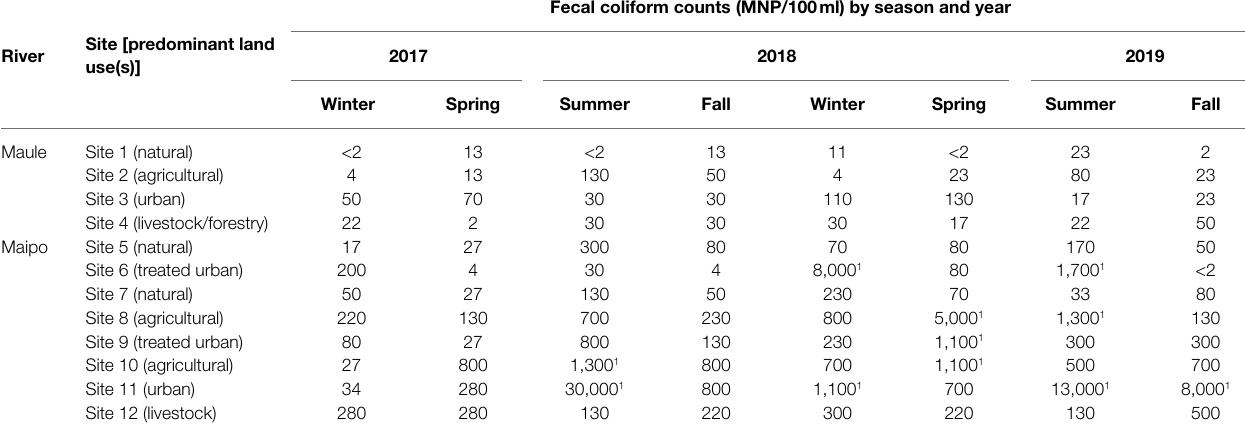
TABLE 1 | Fecal coliform levels (MPN/100 ml) for each sample collected in the Maule and Maipo Rivers between 2017 and 2019.